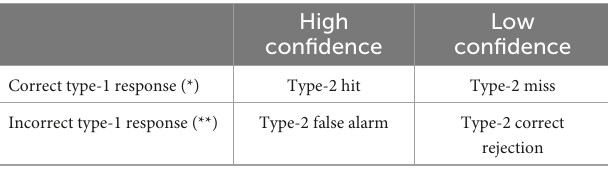
TABLE 2 Type-2 SDT categories for confidence responses and their relation to type-1